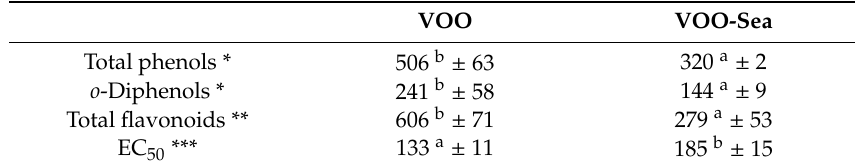
Table 2. Concentrations (mean value ± SD; n = 3) of phenolic compounds in VOO (virgin olive oil) and VOO-Sea (virgin seawater-stored olive oil) and EC 50